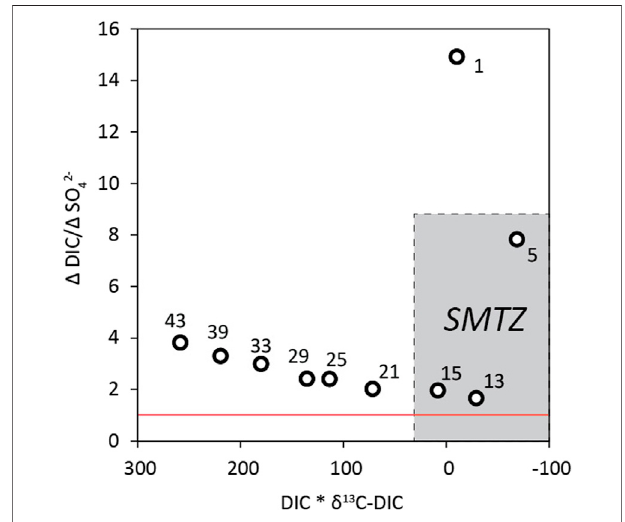
FIGURE 6 | Crossplot of Δ [DIC]/ Δ [SO 42 − ] vs. [DIC] * δ 13 C-DIC for the upper sediment column, after Miller et al. (2017). Delta notation refers to change in concentration with respect to bottom water values. Numbers adjacent to data points indicate depth in cm. Horizontal red line shows the 1:1 ratio predicted for systems dominated by sulfate-mediated AOM ( Eq. 5